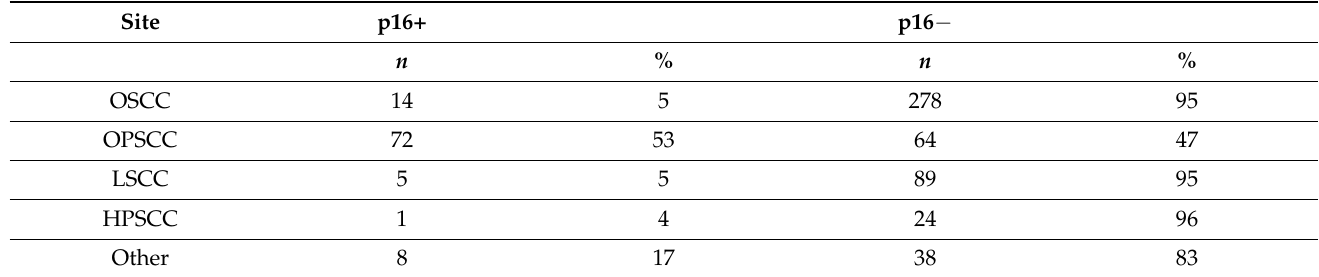
Table 4. p16 staining results by primary tumor location. The “other” group consisted of tumors of the nasal cavity, nasopharynx, sinuses, and tumors of unknown primary location.